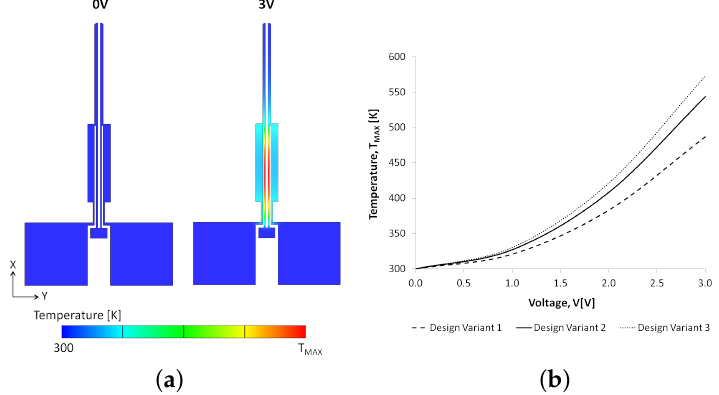
Figure 8. Simulated steady-state temperature distribution on the polysilicon microgripper structures fabricated with PolyMUMPs TM (Design Variants 1-3). The simulated plots in ( a ) show the temperature distribution with and without an applied potential for Design Variants 1-3. The maximum temperature of the actuated microgripper structure is located on the hot arm and is given by T MAX , which is then quantified with applied potential in ( b ) for each specific design